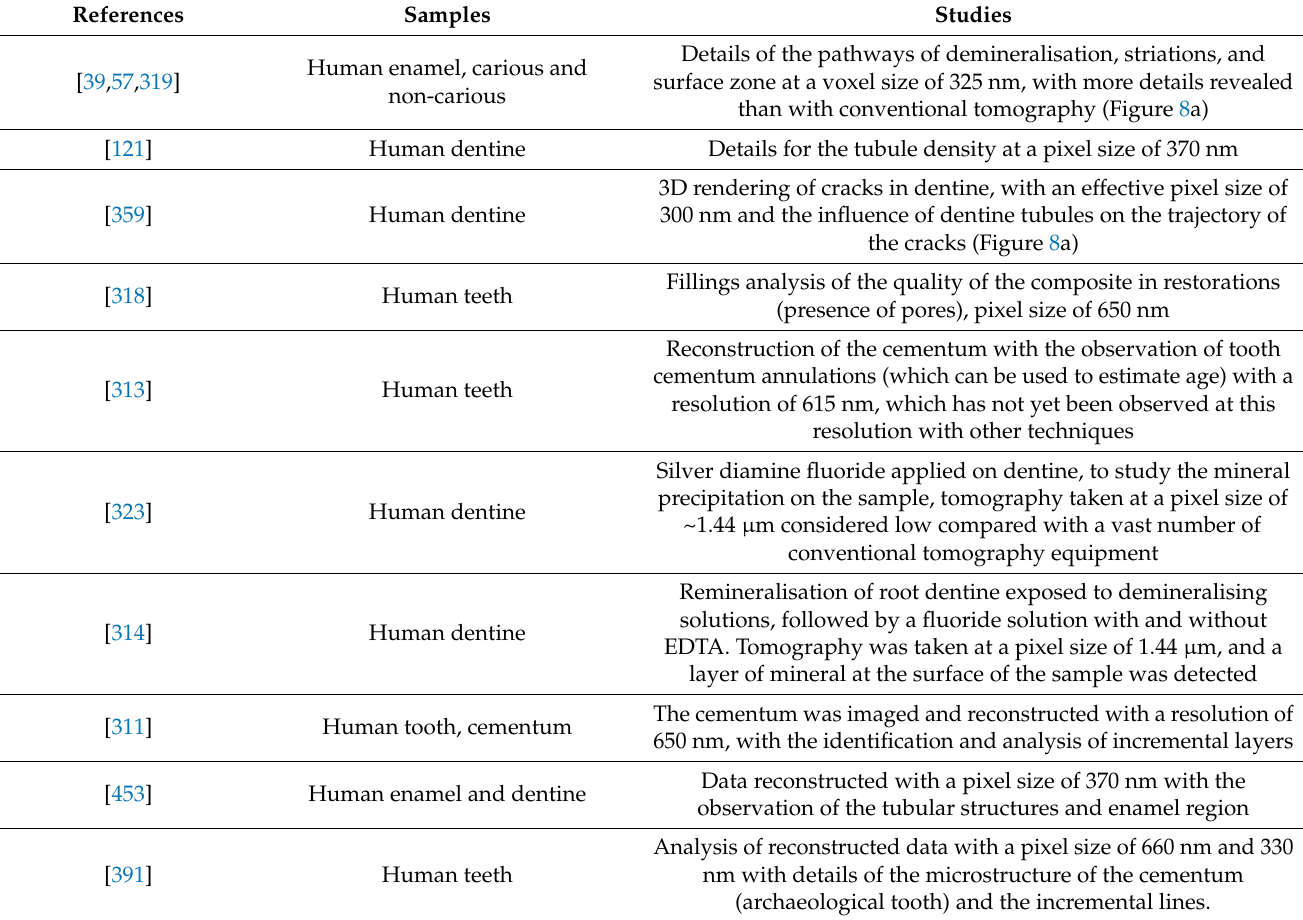
Table 1. Details of the studies carried out on human teeth. Summary of additional studies carried out on the structure of human teeth, with details of